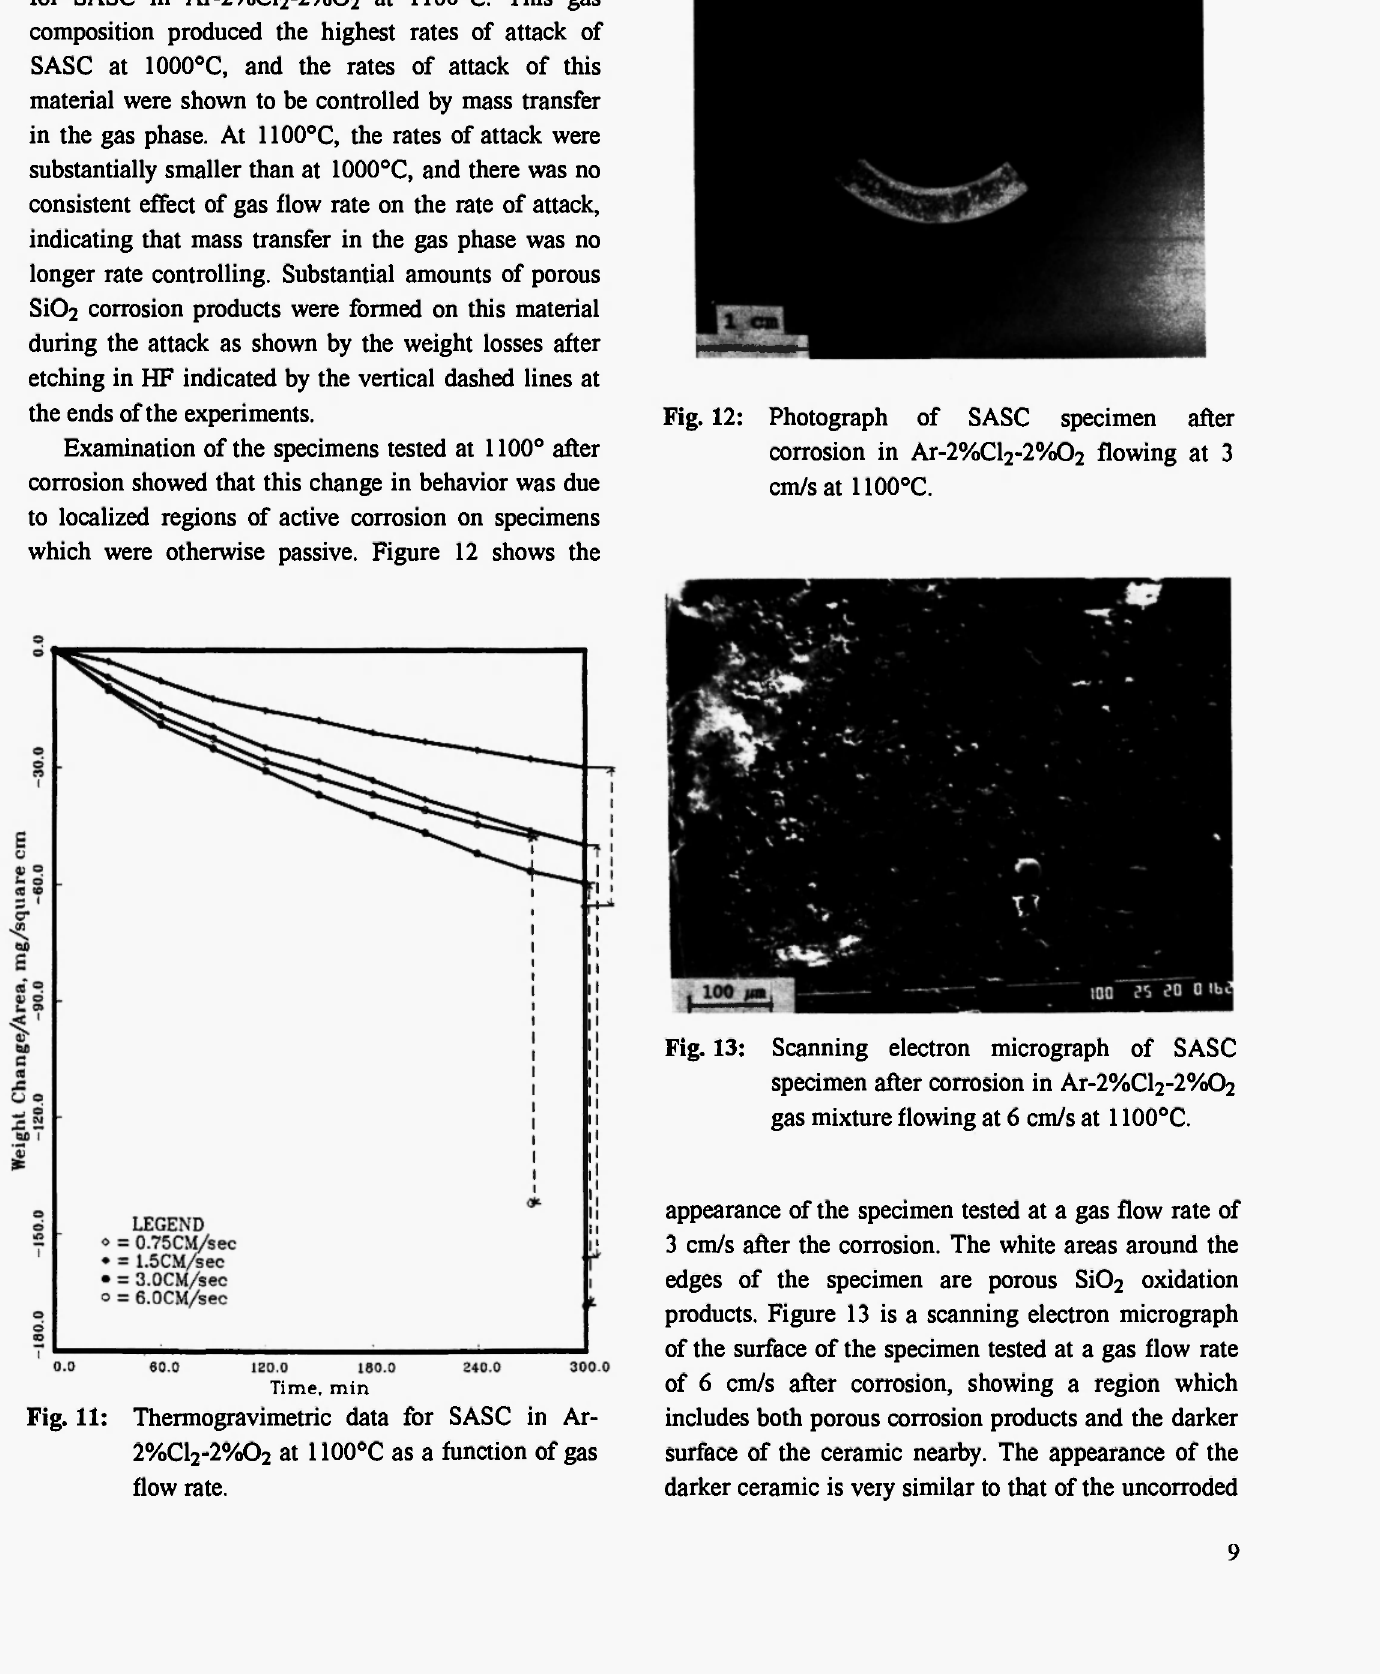
Fig. 11: Thermogravimetric data for SASC in Ar- 2%Cl -2%0 at 1100°C as a function of gas 2 2 flow rate.